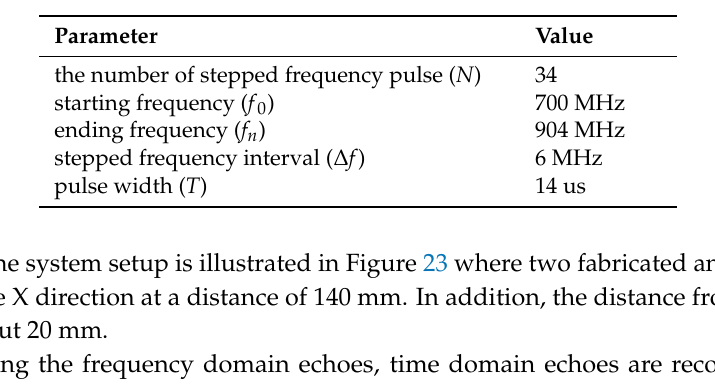
Table 4. Platform's parameter setting.